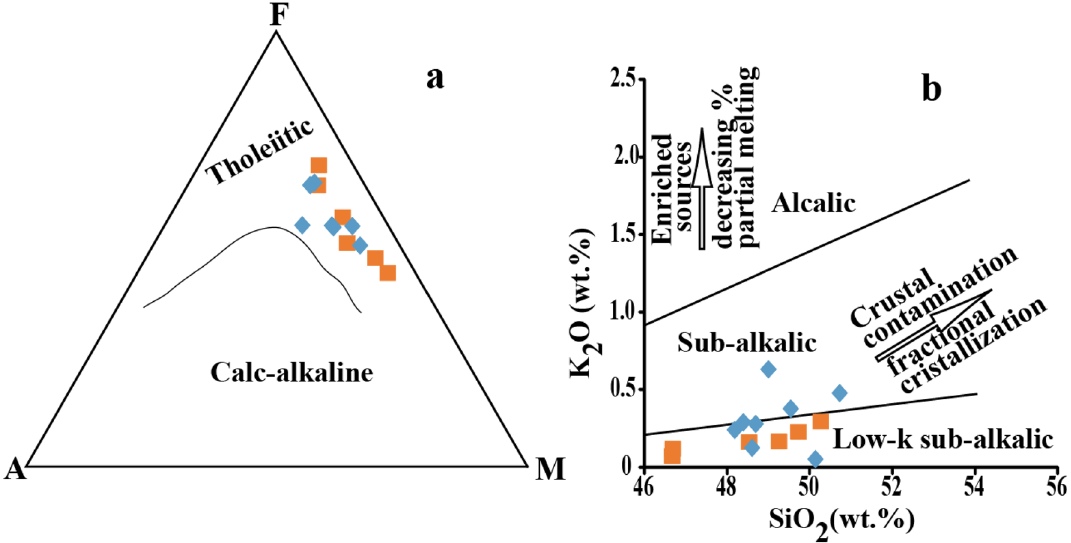
Fig. 8 Nomenclature and classification diagrams of the studied meta-mafic rocks. a AFM ternary diagram (FeOt-Na and b binary diagram K2O vs. SiO